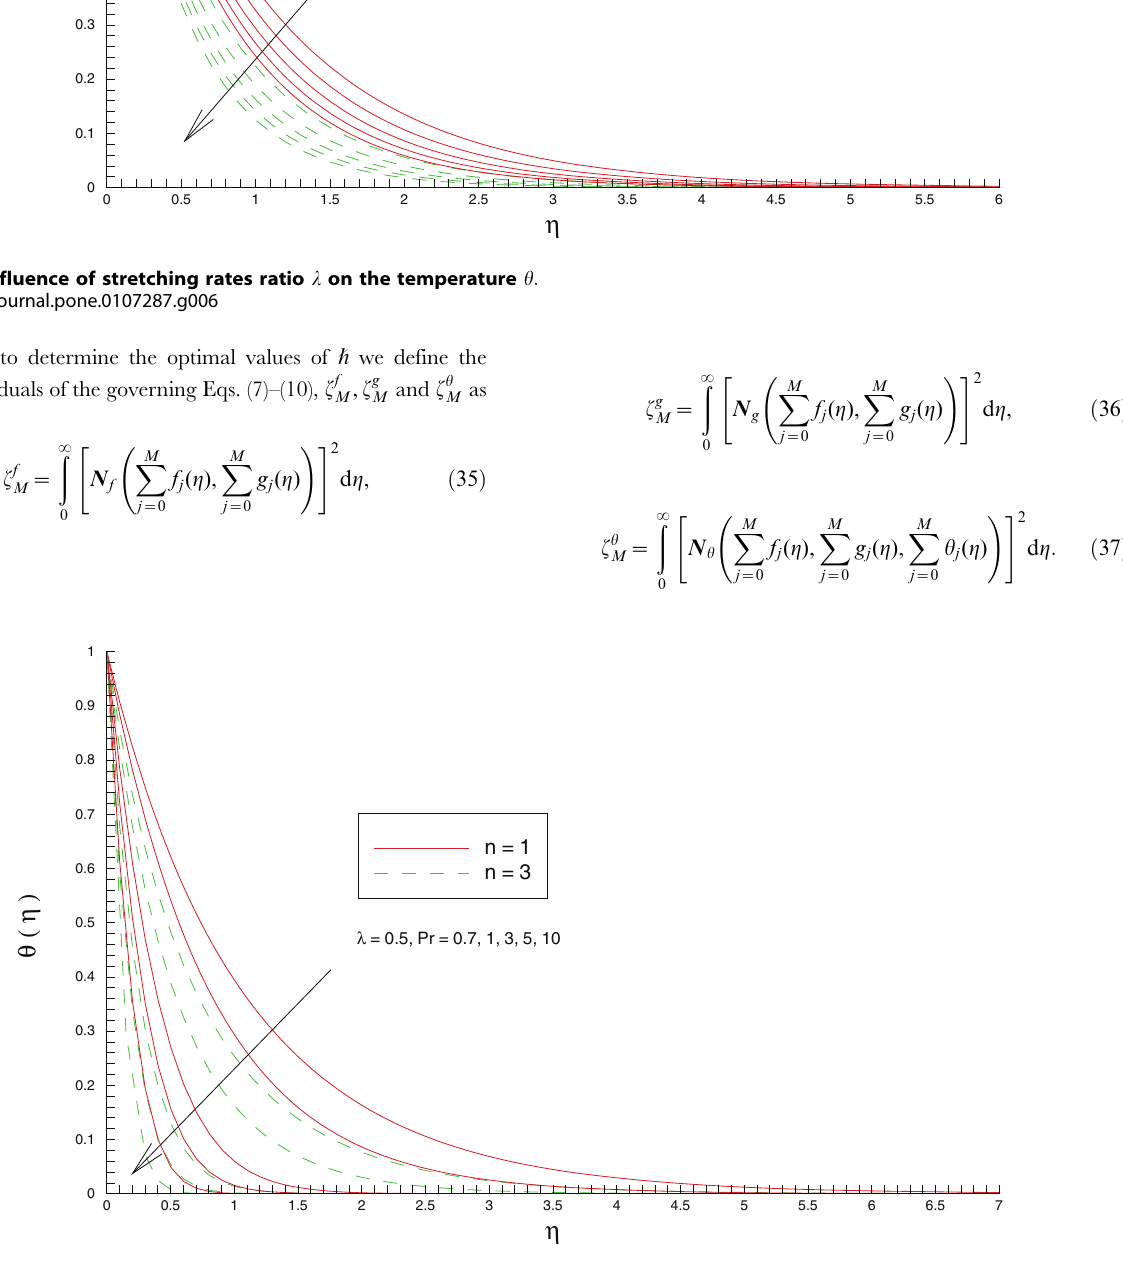
Figure 7. Influence of Prandtl number Pr on the temperature h :